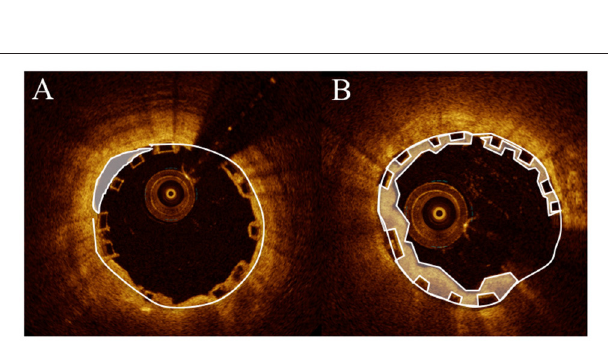
FIGURE 2 | (A) Malapposition (lumen area – scaffold area) = (6.73 – 6.45 mm 2 ) = 0.28 mm 2 . (B) Prolaps area (scaffold area – lumen area) (4.95 cm 2